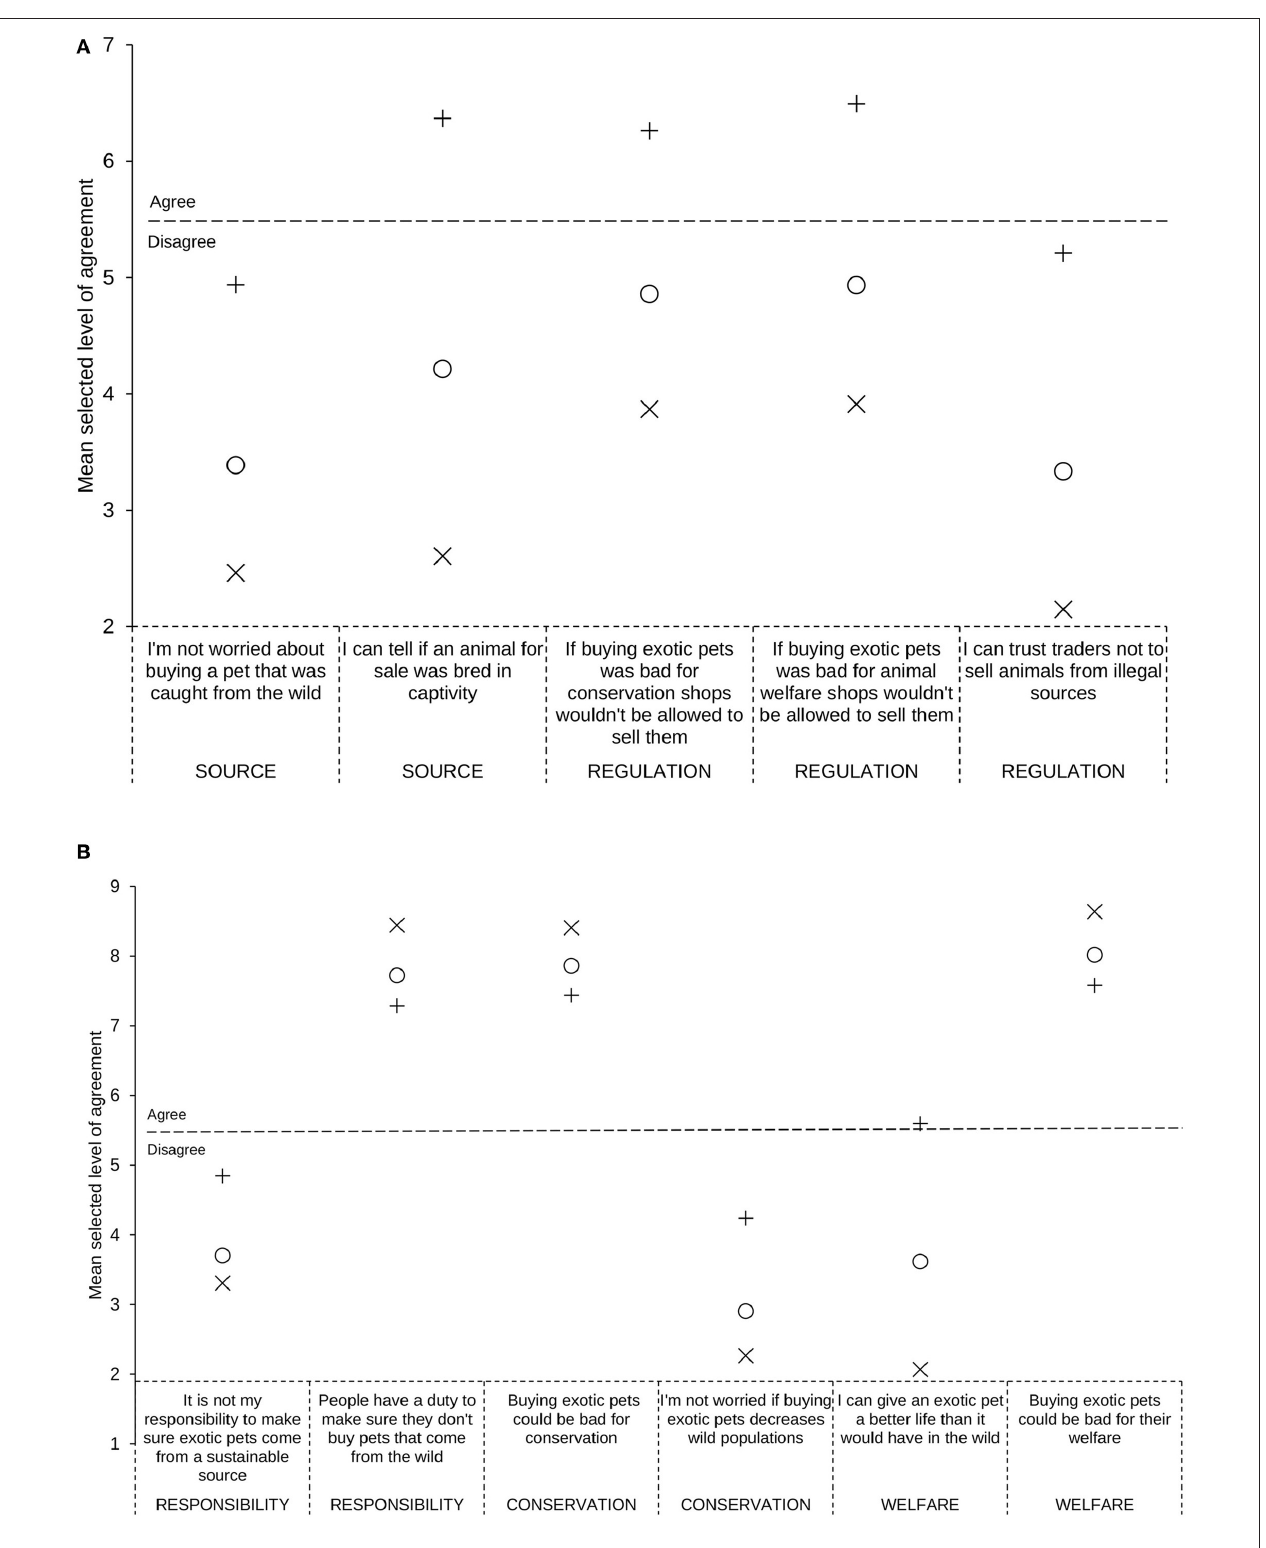
FIGURE 4 | Mean level of agreement (or disagreement) of high likelihood purchasers of exotic pets (“ + ” symbols), medium likelihood purchasers (open circles) and low likelihood purchasers (“ × ” symbols) with attitudinal statements describing (A) the source of exotic pets, and the regulation of impacts of the purchase and (B) Consumers’ responsibilities, and the conservation and welfare impacts of purchasing exotics.